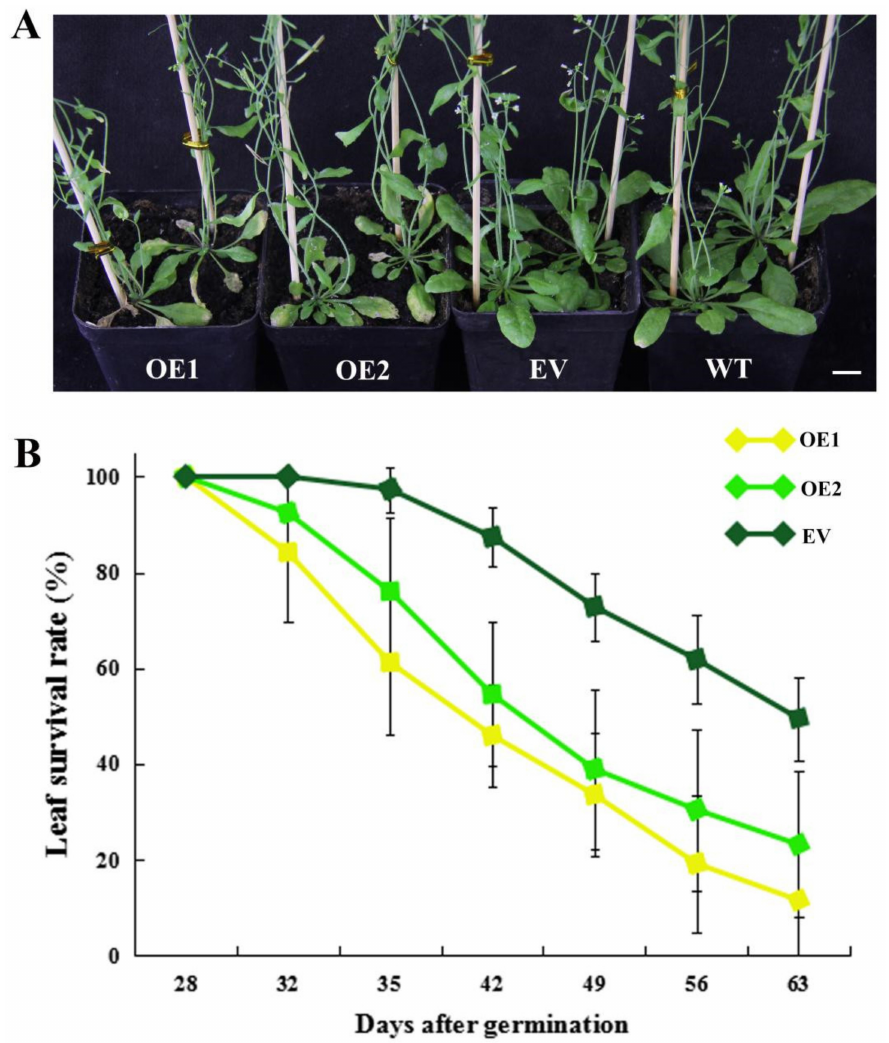
Figure 9. Precocious leaf senescence phenotype of CpWRKY71 OE plants. ( A ) The leaf senescence phenotype of 35-day-old plants. Bar denotes 1 cm. ( B ) Leaf survival curves of OE and EV plants. Data represent the mean ± SD of 20